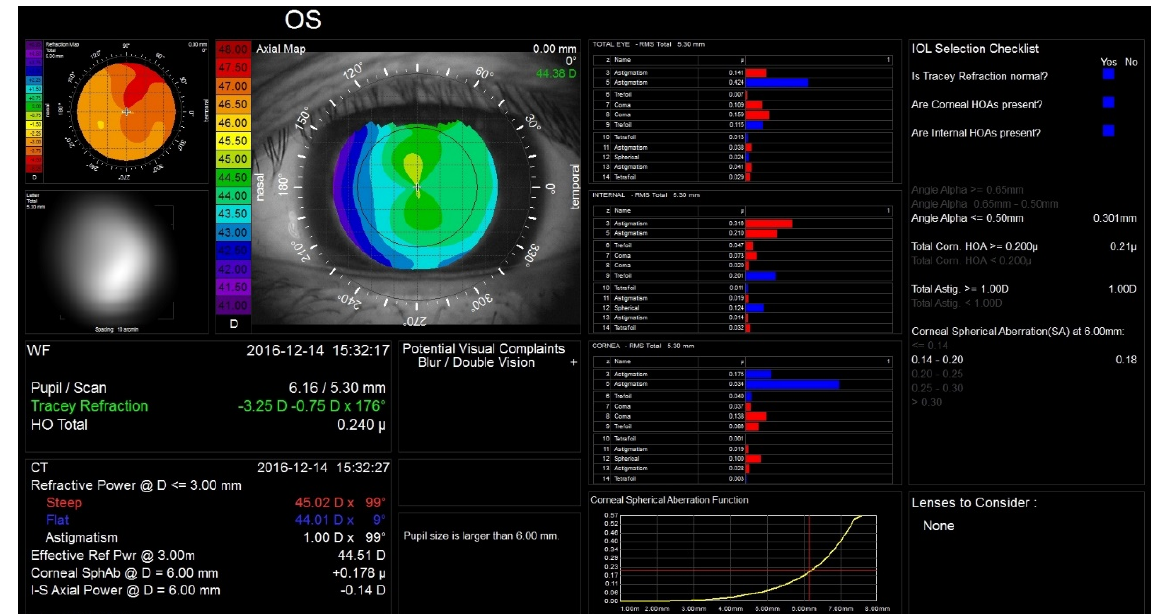
Figure 2. The Tracey iTrace device allows corneal aberrations to be analyzed. Topographical images can also be calculated by projecting other-than-Placido images on the corneal surface. The PAR Technology Corneal Topography System introduced by Belin et al. produced a true topographic map by analyzing a projected grid on the corneal surface [27–29]. Another modality of corneal topography, which is currently available commercially, is color-LED corneal topography. The method was introduced in 1997 [30], and the device was released commercially in the last few years. The Cassini (i-Optics, Hague, Netherlands) corneal topographer is able to analyze the corneal shape based on point-to-point reconstruction of specular reflections of 679 pseudo-random colored points [31]. The potential advantage of this approach over Placido-based systems is that it is not affected by the Placido mismatch, resulting in a proper reconstruction of non-rotationally symmetrical or distorted corneal surfaces [32–34]. In a study by Klijn et al., the magnitude of corneal astigmatism obtained with the Cassini topographer was not different to that obtained with the Pentacam (Oculus Optikgeräte, Wetzlar, Germany), the Lenstar (Haag-Streit, Koeniz, Switzerland) and the Keratotron (Optikon, Rome, Italy) [31]. With that, the repeatability of the cylinder measurements was higher than with the Pentacam or Keratotron ( p < 0.001). Even though the keratometric values obtained with Cassini are similar to those of the Pentacam and IOL Master 500 (Carl Zeiss Meditec AG, Jena, Germany) [35,36] or the Orbscan IIz (Bausch and Lomb Surgical, Rochester, NY, USA) and Lenstar LS-900 (Haag-Streit Holding, Köniz, Switzerland) [37], the wide data spread discourages their interchangeable use to assess corneal power and astigmatism. Color LED topography also enables evaluation of the posterior surface using 2nd Purkinje imaging technology [38]. One might consider that measuring the total instead of anterior corneal astigmatism may decrease the residual astigmatism in toric IOL implantation [39]. The vature and astigmatism in healthy eyes, but only measures of posterior astigmatism could